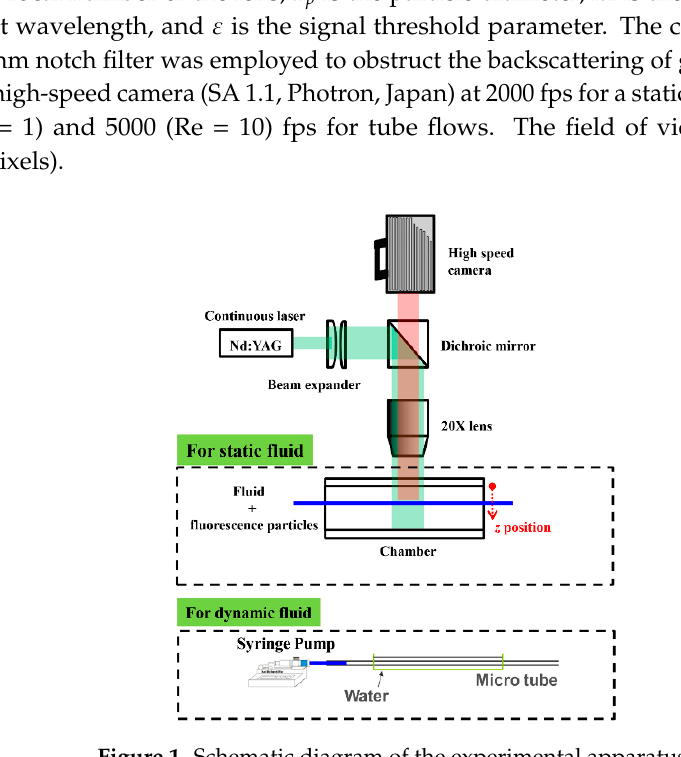
Figure 1. Schematic diagram of the experimental apparatus.